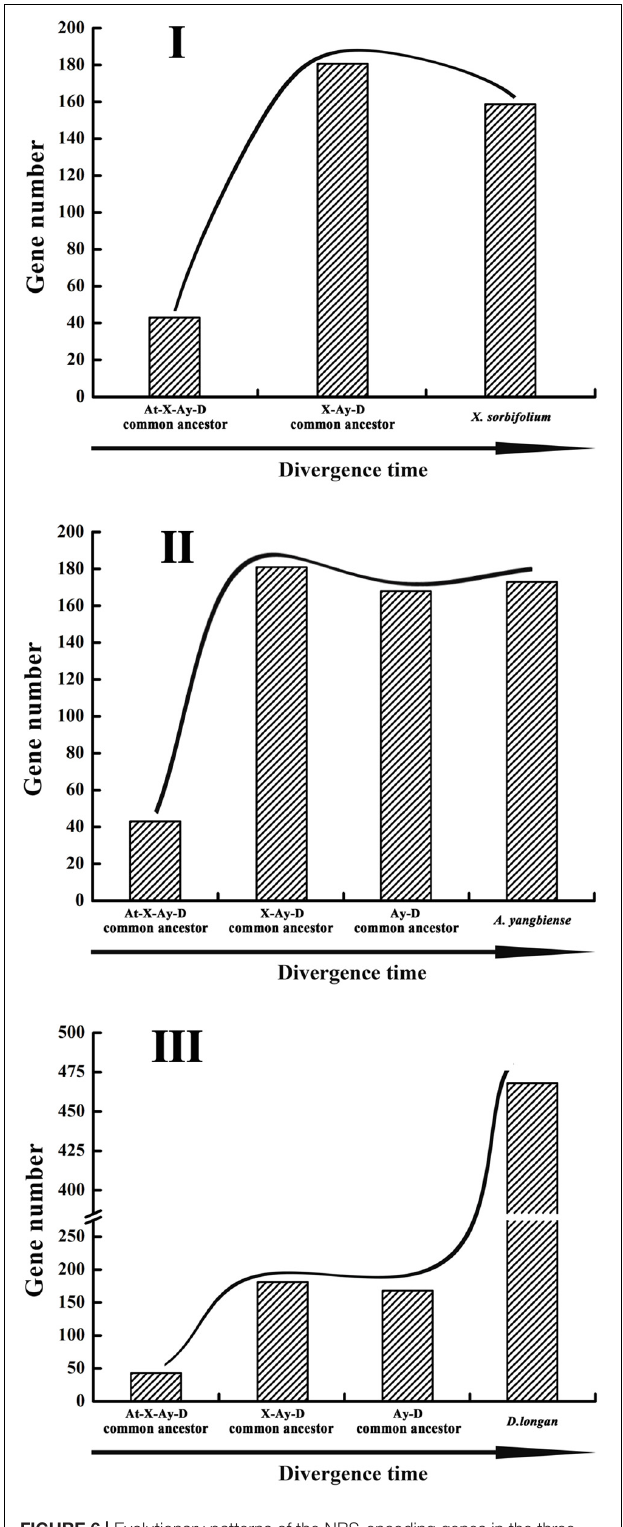
FIGURE 6 | Evolutionary patterns of the NBS-encoding genes in the three Sapindaceae genomes. Gene number variation from the A. thaliana , X. sorbifolium , A. yangbiense , and D. longan (At-X-Ay-D) ancestor to X. sorbifolium (I), A. yangbiense (II), and D. longan